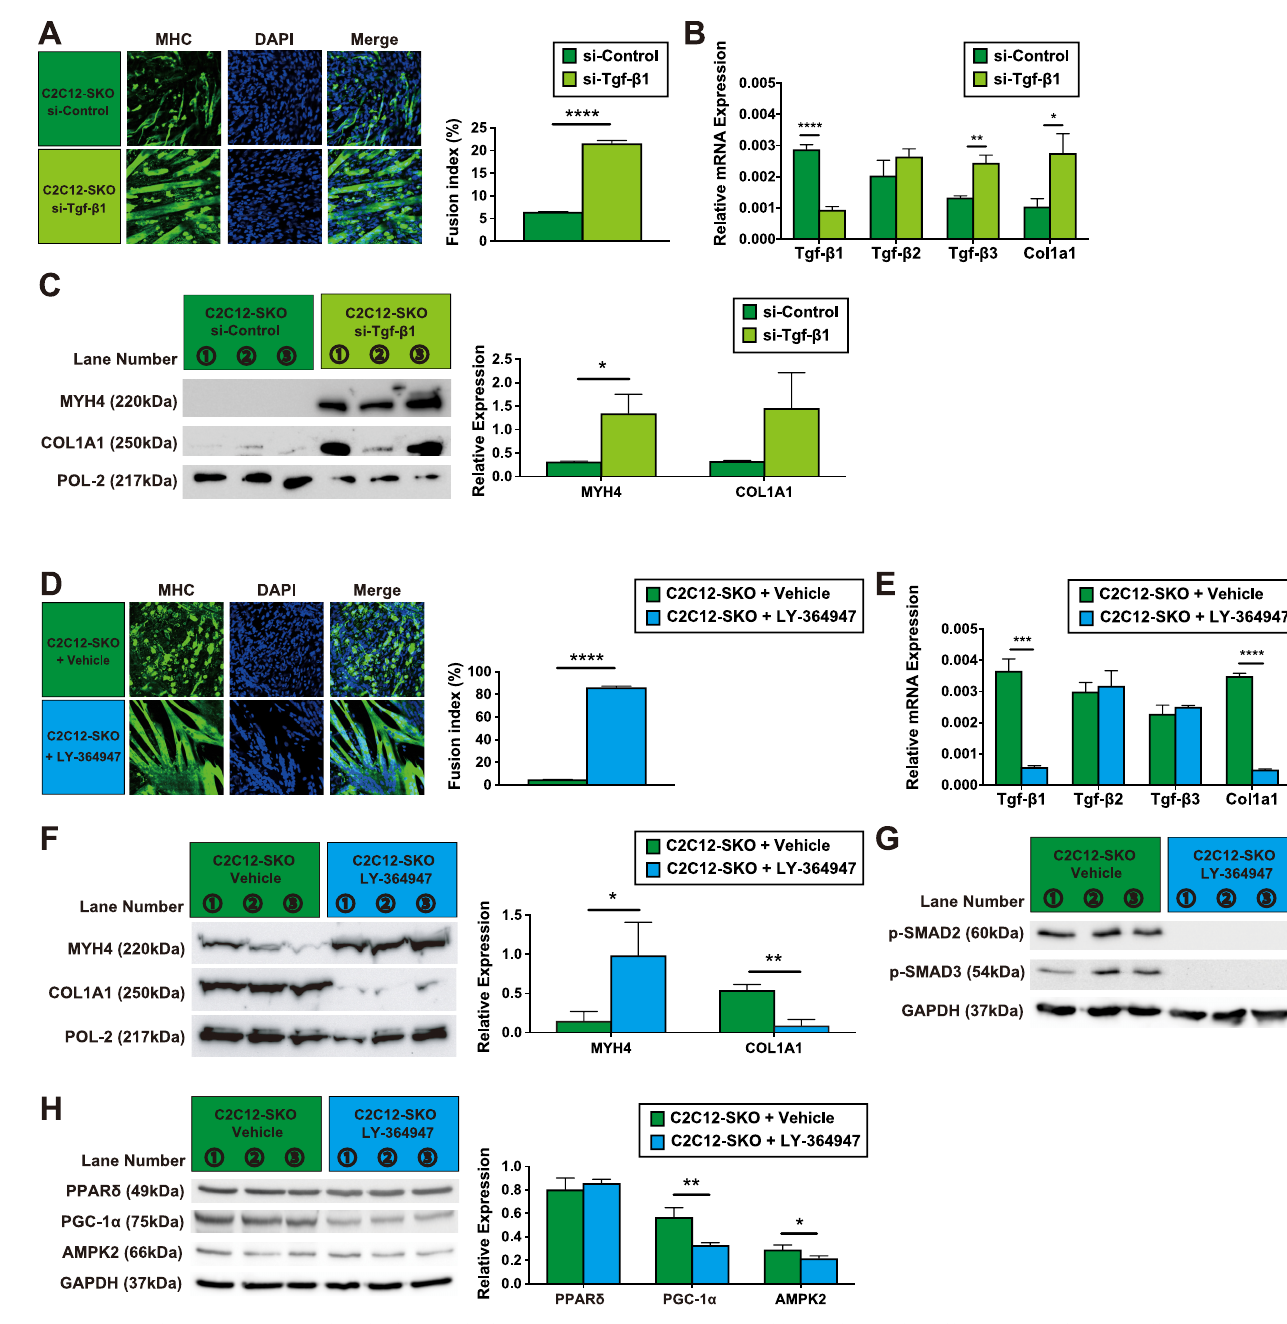
Fig 4. SMRT plays an important role in both myotube formation and protection against fibrosis during the differentiation of C2C12 cells via Tgf- β receptor signaling. (A) Two groups of C2C12-SKO cells treated with either si-Tgf- β 1 or si-Control were induced to differentiate in control medium for 4 days. The expressions of MYH4 in both cells were assessed by IHC. Myotubes were stained by MYH4 (Green). Nuclei were stained by DAPI (Blue). (B) mRNA expressions of Tgf- β isoforms and Col1a1 in two groups of C2C12-SKO cells treated with either si-Tgf- β 1 or si-Control were quantified by qPCR (n = 3 per group). (C) Protein expressions of MYH4 and COL1A1 in two groups of C2C12-SKO cells treated with either si-Tgf- β 1 or si-Control were assessed by WB (n = 3 per group). (D) Two groups of C2C12-SKO cells treated with either vehicle or LY-364947 were induced to differentiation in control medium for 4 days. The expressions of MYH4 in both cells were assessed by IHC. Myotubes were stained by MYH4 (Green). Nuclei were stained by DAPI (Blue). (E) mRNA expressions of Tgf- β isoforms and Col1a1 in two groups of C2C12-SKO cells treated with either vehicle or LY-364947 were quantified by qPCR (n = 3 per group). (F) Protein expressions of MYH4 and COL1A1 in two groups of C2C12-SKO cells treated with either vehicle or LY-364947 were assessed by WB (n = 3). per group). (G) Protein expressions of p-SMAD2 and p-SMAD3 in two groups of C2C12-SKO cells treated with either vehicle or LY-364947 were assessed by WB (n = 3 per group). (H) Protein expressions of PPAR δ , PGC-1 α , and AMPK2 in two groups of C2C12-SKO cells treated with either vehicle or LY-364947 were assessed by WB (n = 3 per group). Student t-tests were used for statistical analyses in all qPCR and quantification of protein expression. Results are shown as the mean ± SEM (error bars represent SEM), and the p-value are shown as ���� p < 0.0001, ��� p < 0.001; �� , p < 0.01; � , p < 0.05. https://doi.org/10.1371/journal.pone.0277830.g004 PLOS ONE | https://doi.org/10.1371/journal.pone.0277830 December1,